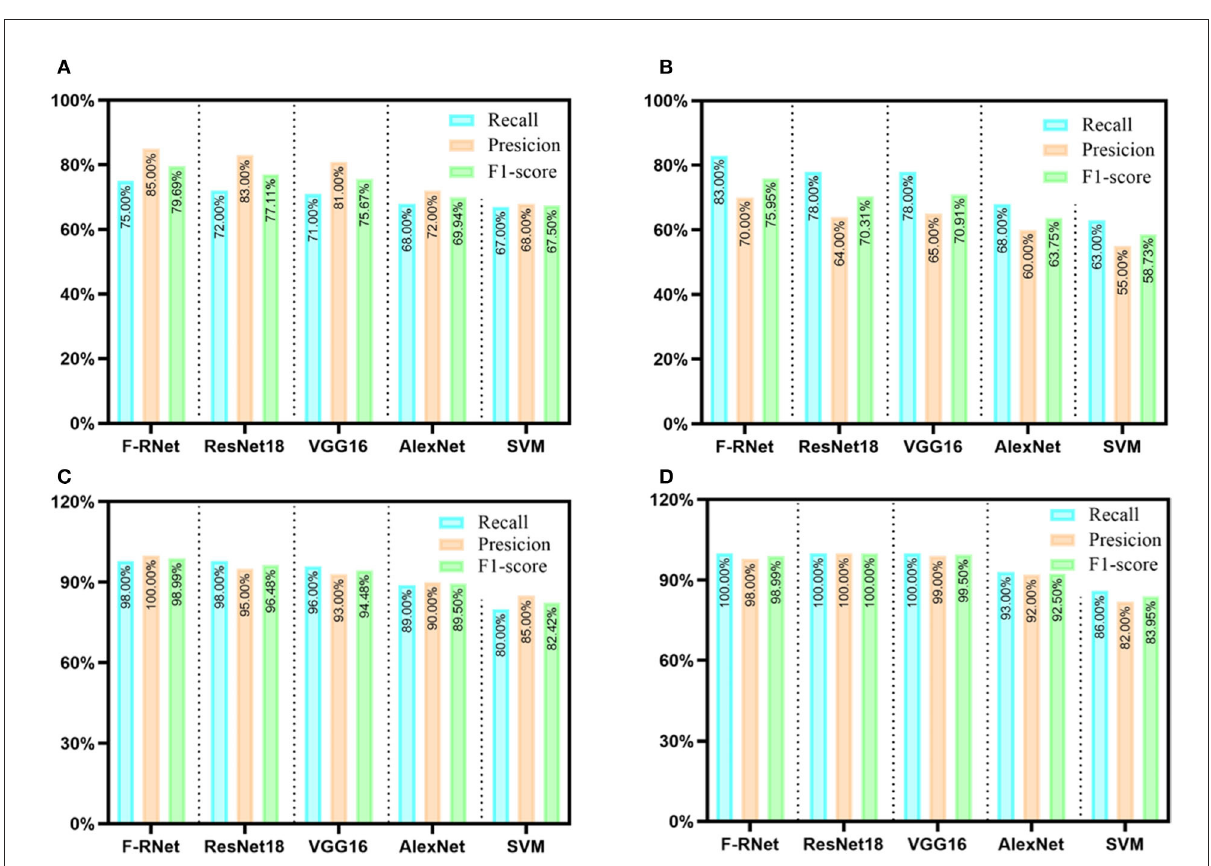
FIGURE11 Evaluation results of different disease spots and insect spots by different network models. (A) BB; (B) TS; (C) TC; and (D)